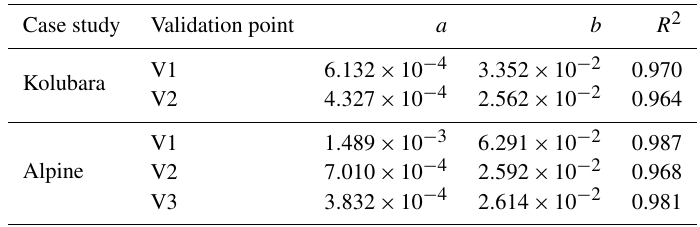
Table A2. Polynomial fit coefficients and coefficients of determination for the d (RMSD) relationships.